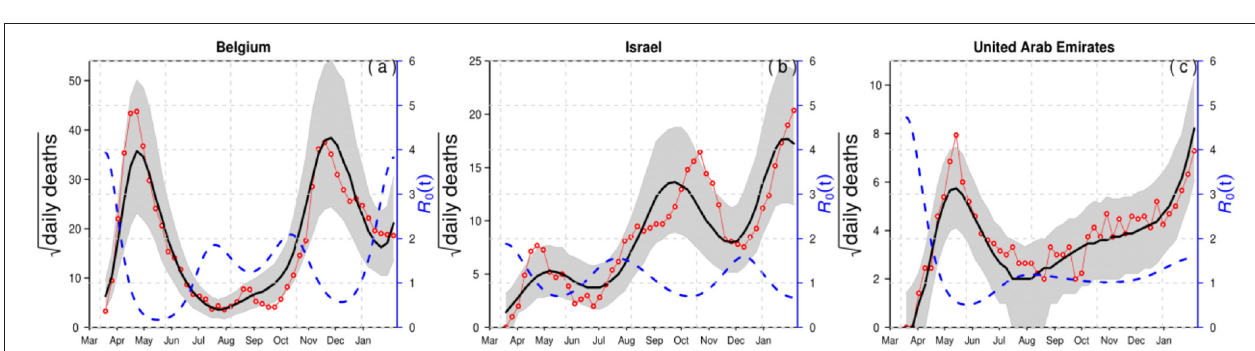
FIGURE 2 | Time-series fitting results of daily confirmed COVID-19 deaths (in red circled) in (a) Belgium, (b) Israel, and (c) the United Arab Emirates represented, respectively. The medium of the simulation is represented by the black curve, and the time-varying effective reproduction number [ R 0 ( t )] is denoted in the blue dashed curve. The 95% confidence interval of the simulation is shown by the shaded (gray) region. The mean LP = 2 and the mean IP = 3.